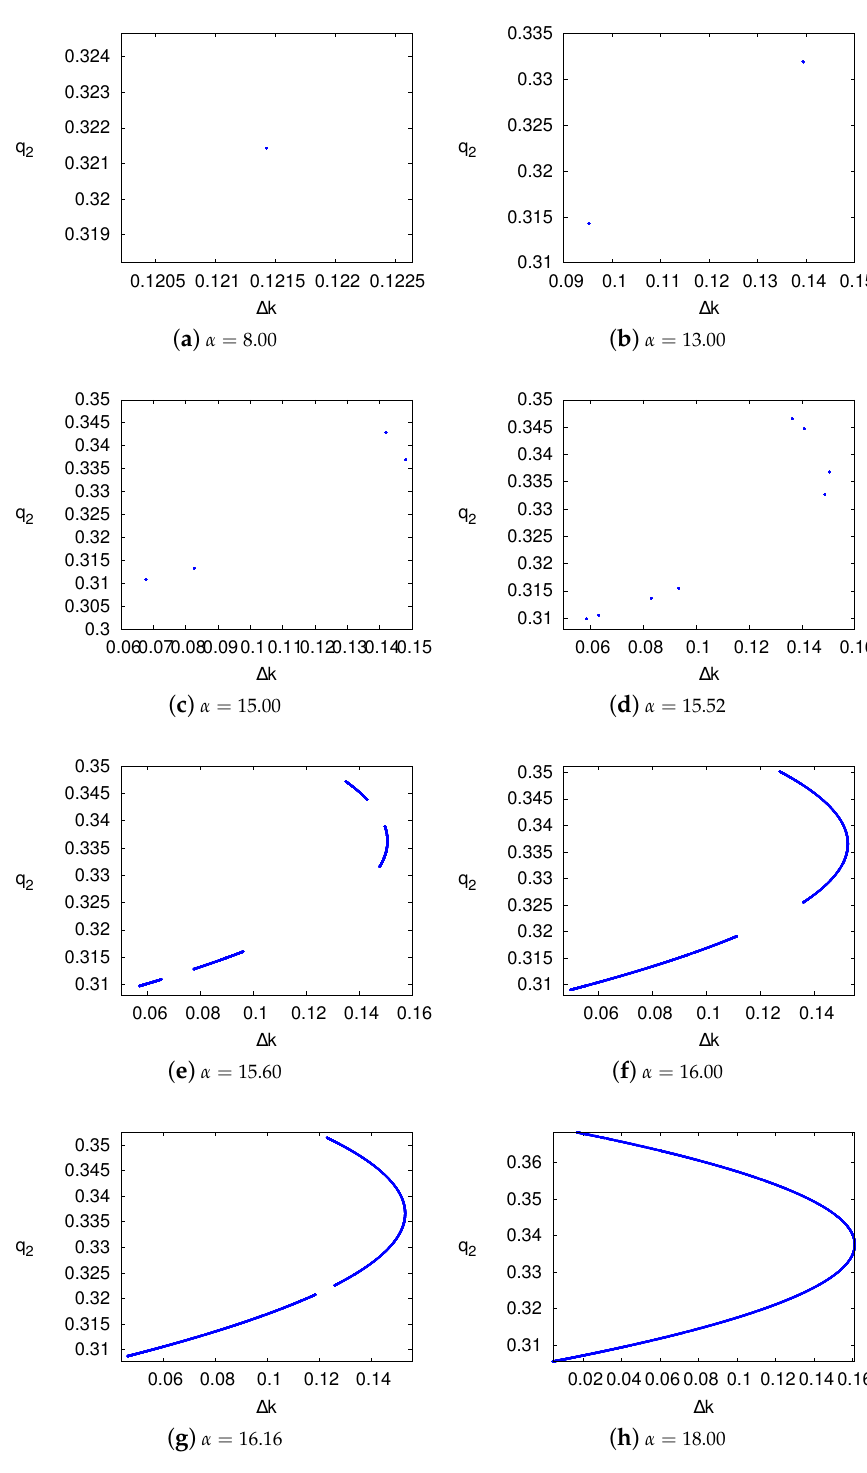
Figure 5. The chaotic attractors w.r.t α